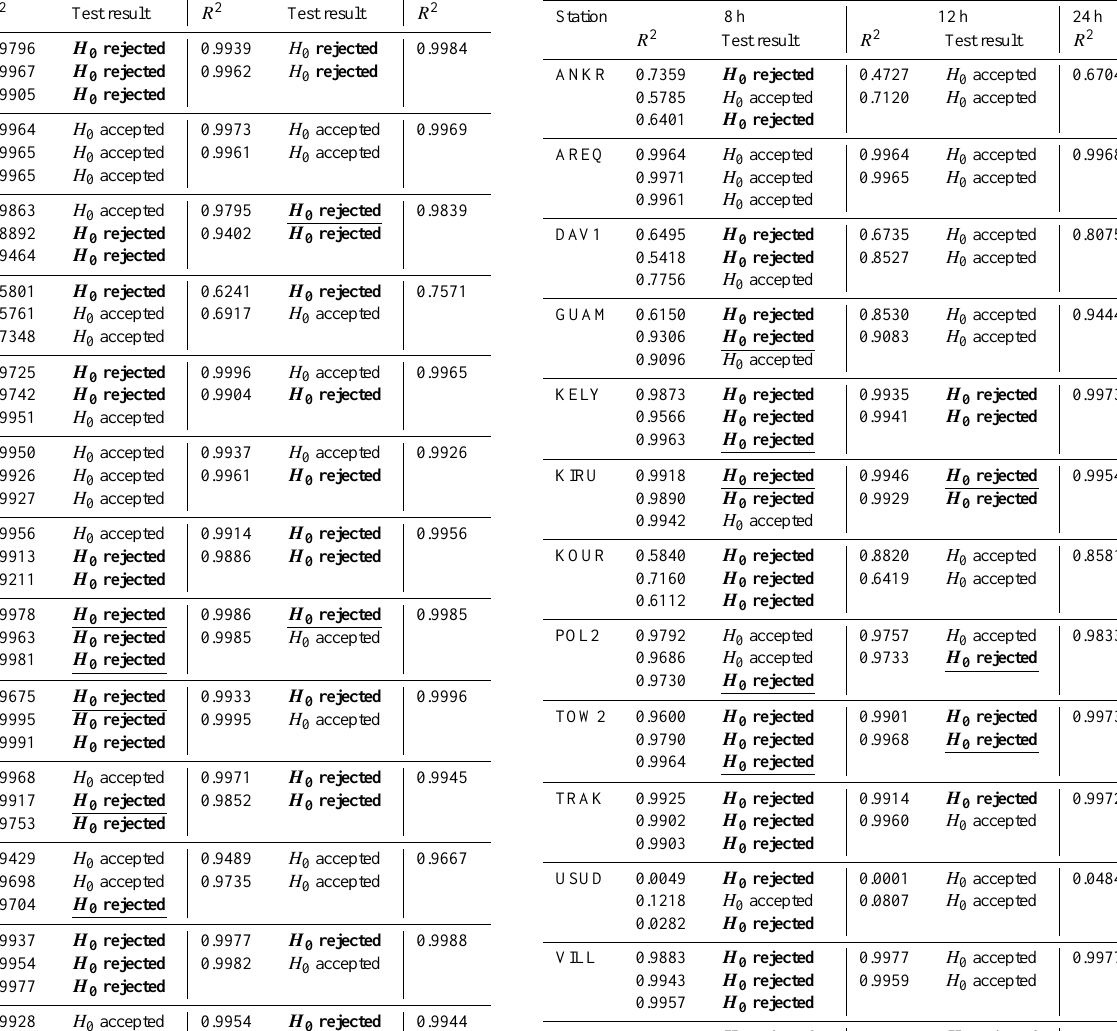
Table 3. Hypothesis testing results for longitude: rejections indi- cated in bold-faced letters are related to an F test; rejections indi- cated in underlined bold-faced letters are from Student’s t test; the stations with R 2 values smaller than 0.99 are not used in the evalu-